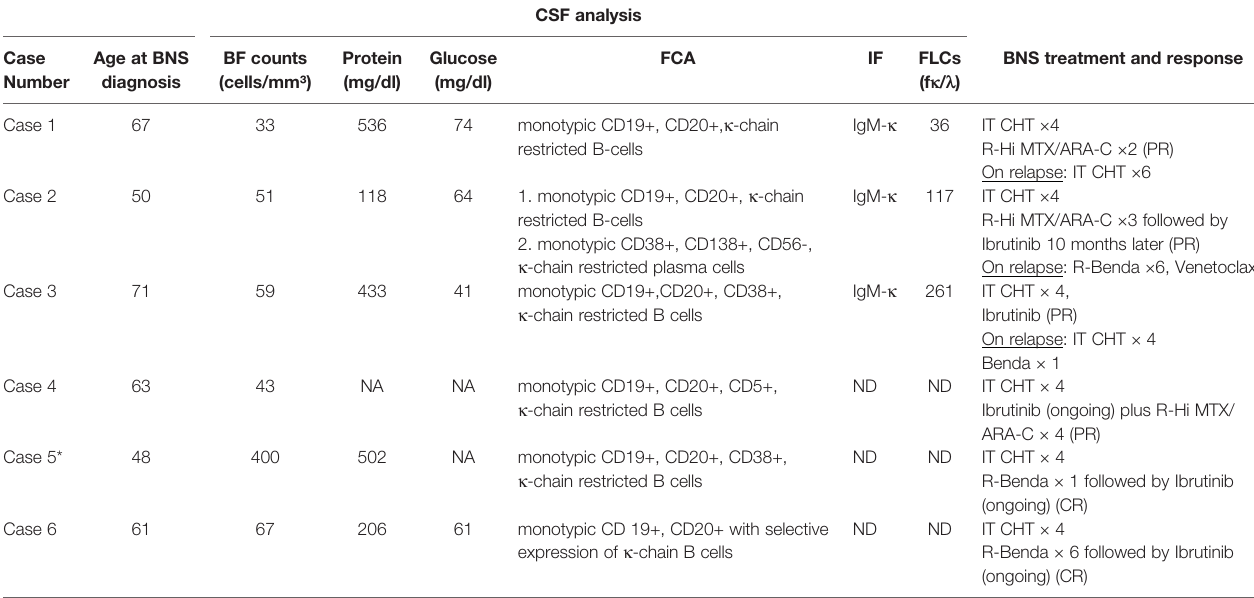
TABLE 2 | Summary of BNS characteristics.